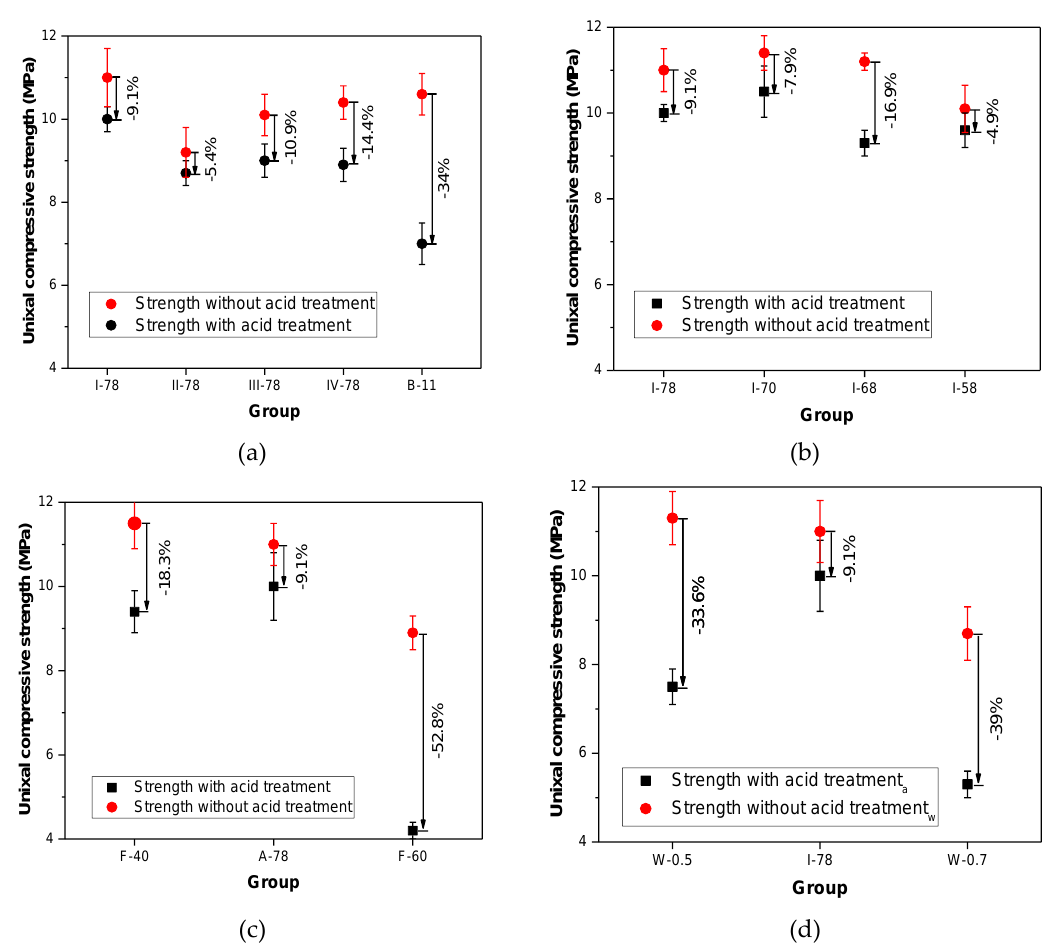
Figure 8. Uniaxial compressive strength of the FGM specimens immersed in acid and water. ( a ) Coal gangues types and binder volume effect; ( b ) Aggregate gradation effect; ( c ) Fly ash proportion effect; ( d ) Water to cement ratio effect.